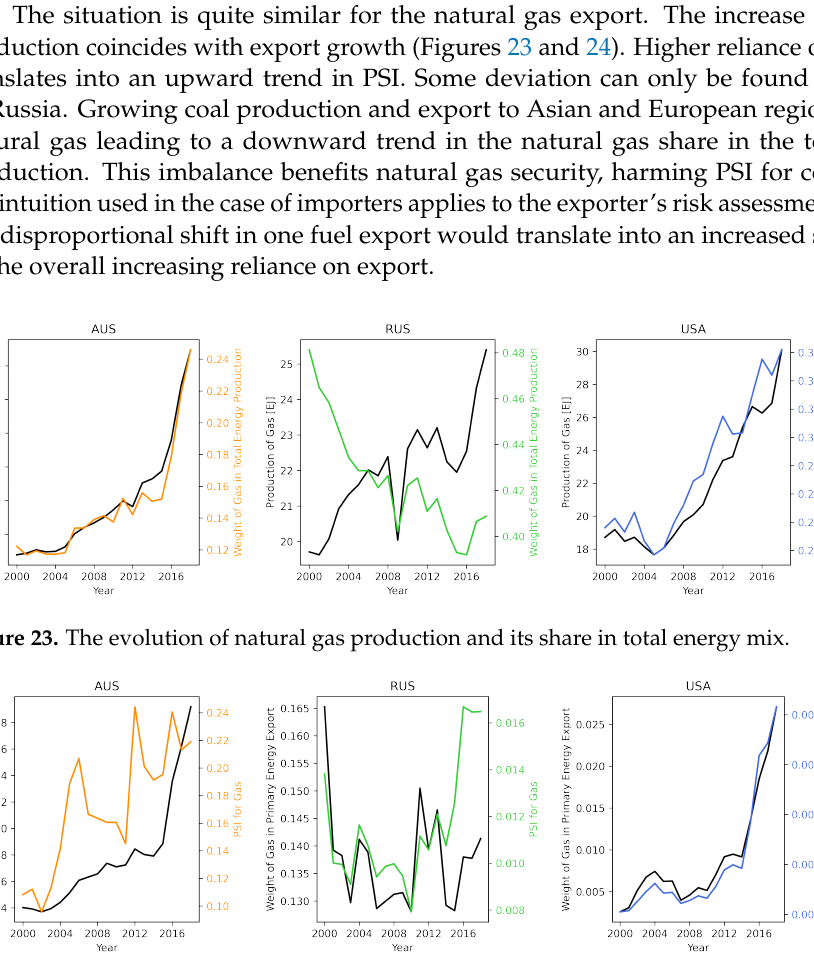
Figure 24. The evolution of PSI for natural gas